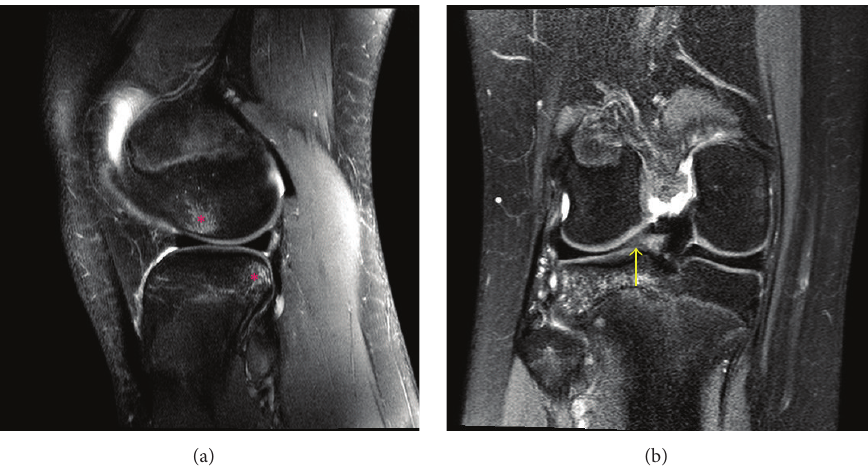
Figure 11: A 13-year-10-month-old female with FOPE zone of the distal right femur. Findings: (a) sagittal proton density fat-saturated image shows pivot-shift pattern of bone marrow edema at the weight-bearing aspect of the lateral femoral condyle and posterior aspect of the lateral tibial plateau (asterisks). (b) Coronal proton density fat-saturated image shows increased signal in the lateral meniscus posterior horn root ligament (arrow) consistent with tearing of the ligament. Tear of the root ligament was confirmed on arthroscopy. Technique: (a) sagittal PD fat-saturated MRI (TR = 2,557, TE = 30), ST = 3 mm, spacing = 3.3 mm, FOV = 14 cm, and matrix = 364 × 261; (b) coronal PD fat-saturated MRI (TR = 2,826.1, TE = 30), ST = 2.5 mm, spacing = 3.3 mm, FOV = 15 cm, and matrix = 312 × 244.